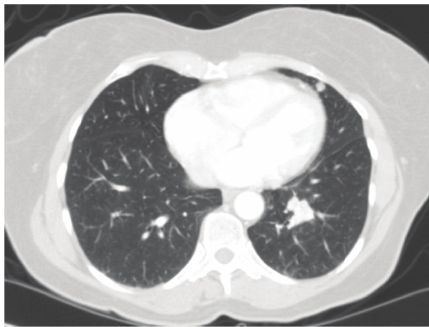
Figure 1: Imaging study. Computed tomography of the chest reveals a 2.0 × 1.6cm mass and a stable nodule in the left lower lobe.